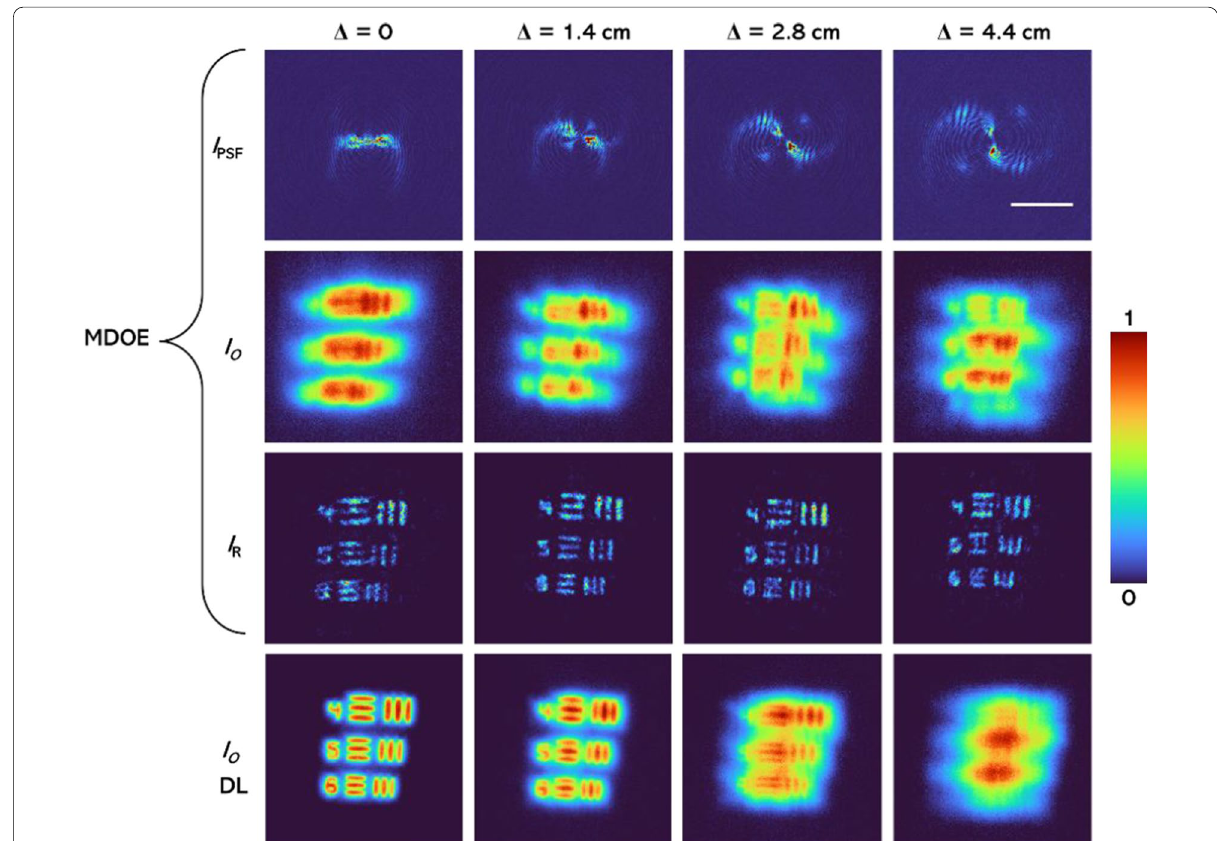
Fig. 9 Experimentally recorded I PSF , I O , and the reconstruction results using NLR with ( α images obtained for DL. The scale bar is 0.5